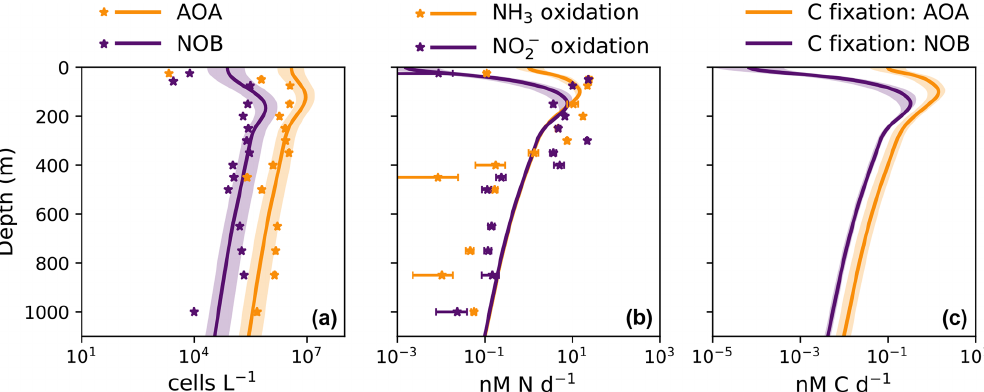
Figure 3. Water column model solutions compared to observations in the western Pacific Ocean. Solid lines are model solutions, and marked points are measurements from Zhang et al. (2020). The shaded areas denote the 5th and 95th percentiles of the ensemble of model solutions in which the AOA and NOB parameter values are varied. (a) Abundances of ammonia-oxidizing archaea (AOA; measured with amoA ) and nitrite-oxidizing bacteria (NOB; measured with 16S). (b) NH 3 and NO − oxidation rates. (c) Model prediction of the carbon fixation rates 2 associated with AOA and